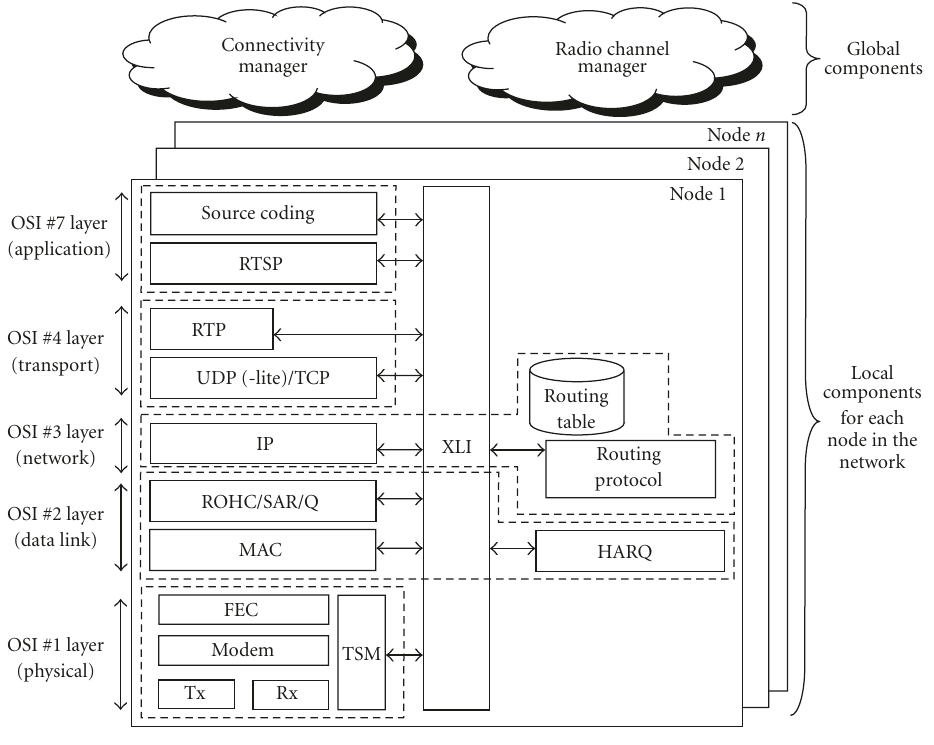
Figure 1: Overall protocol